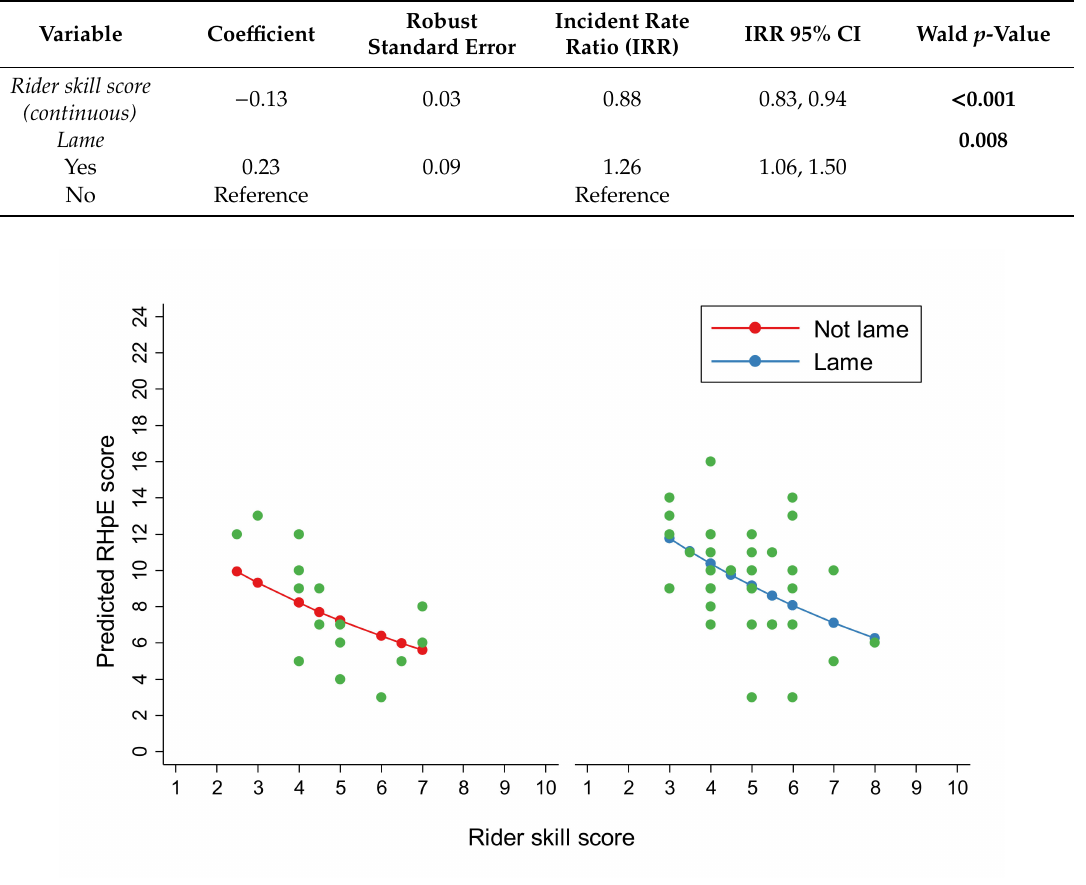
Figure 2. Prediction of linear Ridden Horse Pain Ethogram (RHpE) scores based on rider skill score (0–10) and lameness status (red = non-lame; blue = lame), as estimated by a multivariable Poisson regression model with robust standard errors. Individual points (green) represent the original data used to make these linear